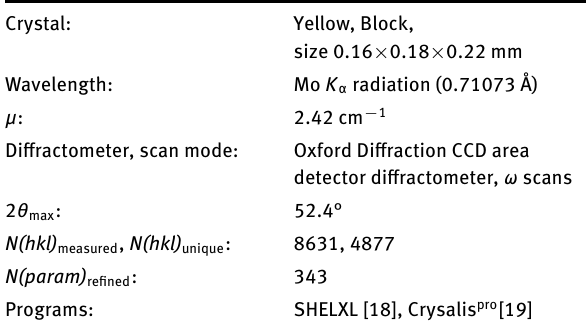
Table 1: Data collection and handling.